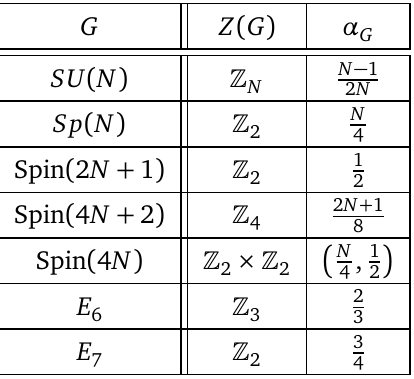
Table 2: Coefficients of the fractional instanton density for non-trivial background B . For Spin ( 4 N ) we have two contributions given by P ( B ( L ) + B ( R ) ) and B ( L ) ∪ B ( R ) ,